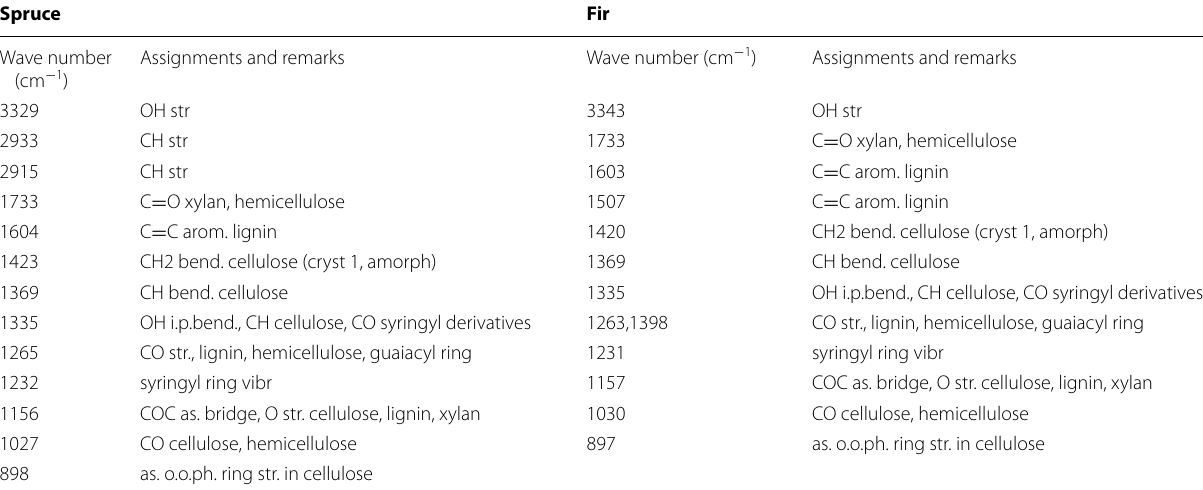
Table 2 Main bands in FT-IR spectra of the studied wood samples Spruce Fir